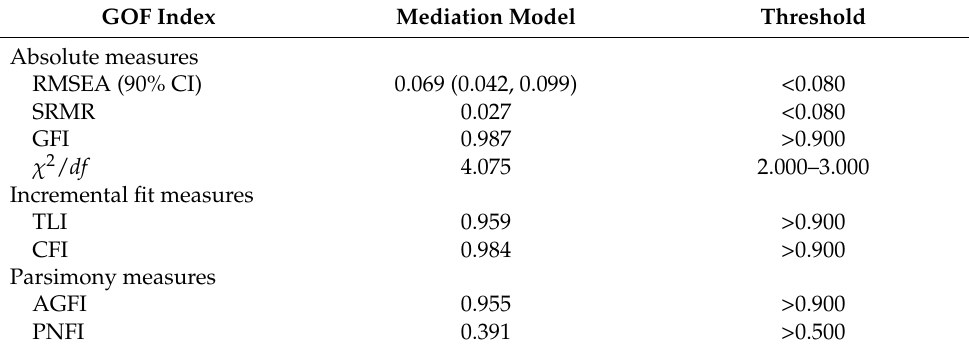
Figure 2. Path coefficients for simple mediation analysis on sleep quality ( n = 637). ( A ) The total effect of sleep quality on health condition and ( B ) the effect of sleep quality on self-rated health when anxiety and depression are included as a mediator. Note: Dotted line represents the effect of sleep quality on health condition when anxiety and depression are included as a mediator. Factor loadings are standardized. a, b, c, and c’, standardized regression coefficients; e, measurement errors; SDS, Sleep Difficulty Subscale; DSS, Daytime Sleepiness Subscale; Self-Psy, Self-Rated Psychological Condition; Self-Phy, Self-Rated Physical Condition; SE, Standard Error; IE, Indirect Effect; DE, Direct Effect; *** p < 0.001; ** p < 0.010; * p < 0.050. Table 2. Evaluation of the goodness-of-fit of the models ( n =